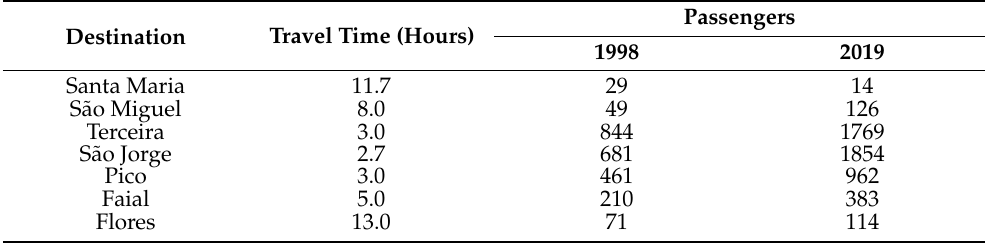
Table 4. Data for maritime connections to Graciosa Island from the rest of the archipelago—for 1998 and 2019.